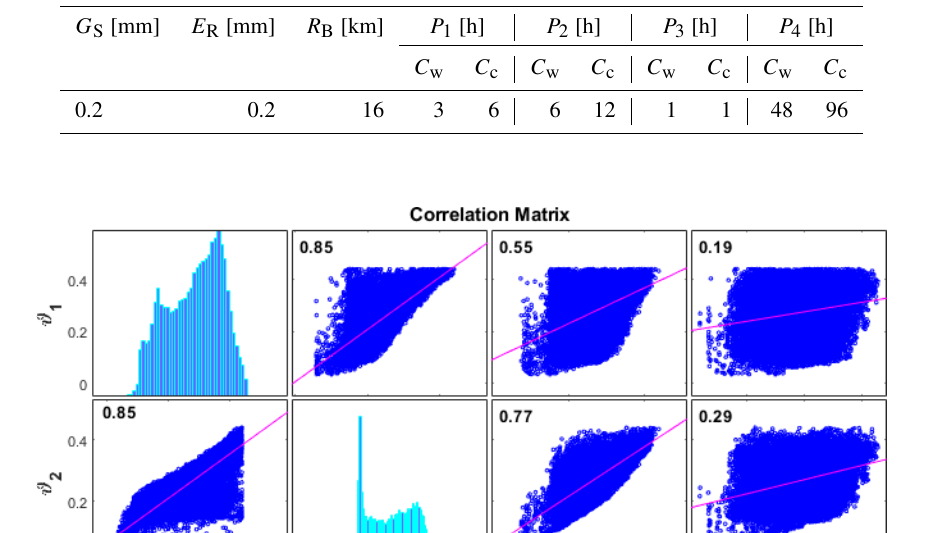
Table 2. CTRL-T parameters for the reconstruction of the rainfall events used in the present study.